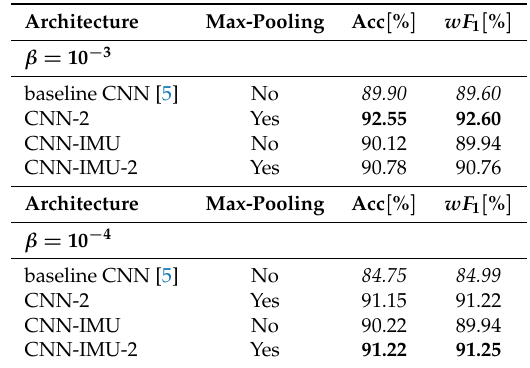
Table 9. Validation accuracies and Weighted F1 for the architectures with and without max-pooling operations on the Pamap2 dataset.